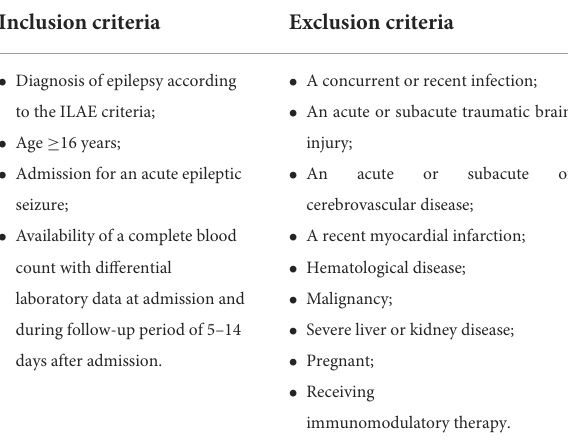
TABLE 1 The inclusion and exclusion criteria of patients with